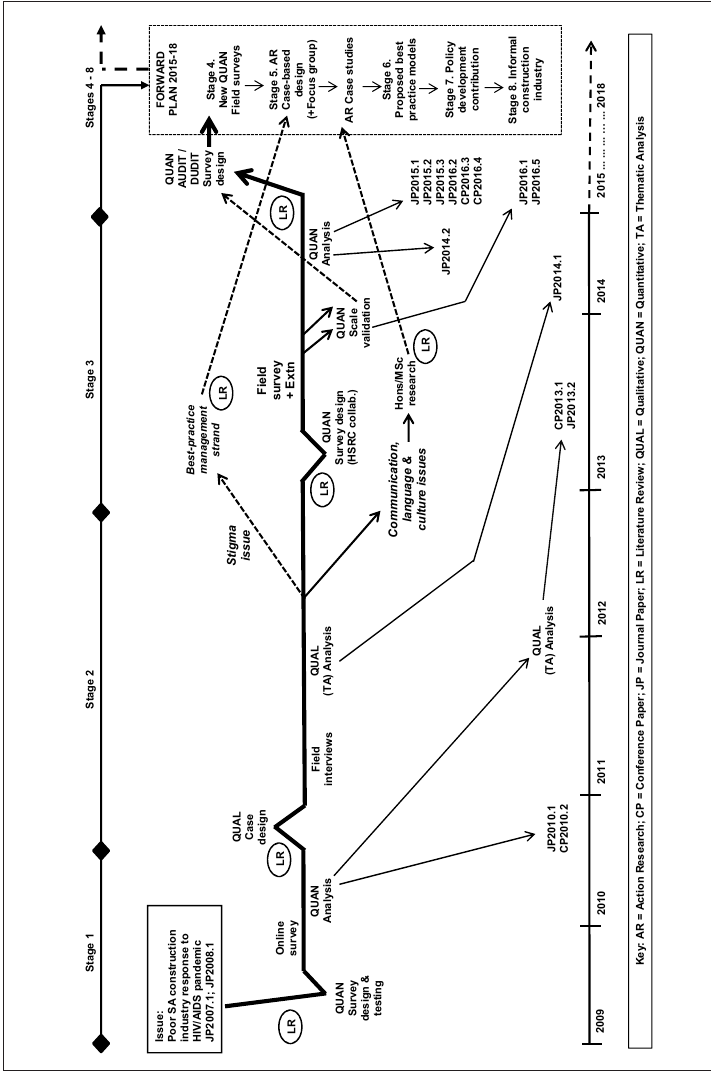
Figure 1: HIV/AIDS intervention management in the South African construction industry: SMMR Research Journey